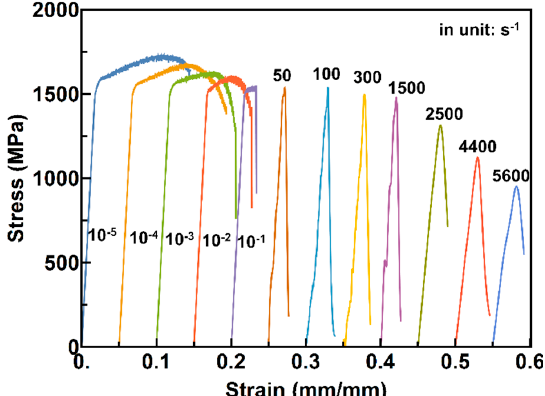
Figure 5. Stress–strain relationship of ZC3 under different strain rates.